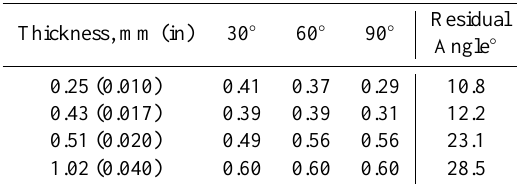
Table 3. Variation in hinge indexes and residual angles for di ff erent thicknesses of polypropylene.